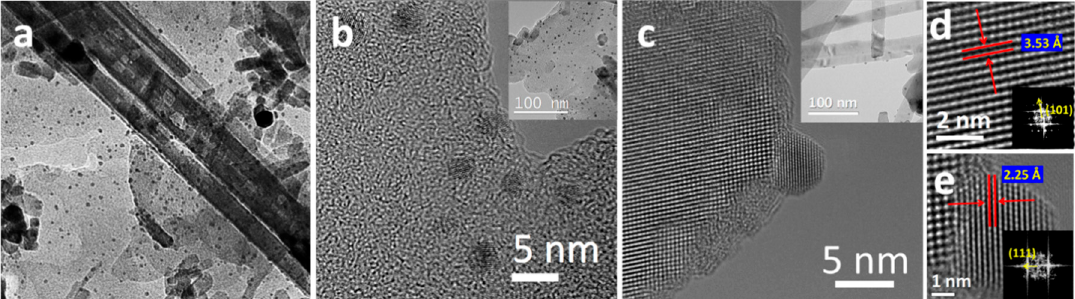
Figure 7. TEM images of ( a ) Pd/TiO 2 /g-C 3 N 4 catalyst; magnified images of ( b ) g-C 3 N 4 NS and ( c ) TiO 2 NF decorated with Pd NP; HRTEM images of ( d ) TiO 2 NF, and ( e ) Pd NP.